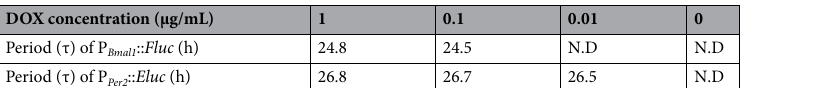
DOX concentration (µg/mL) 1 0.1 0.01 0 Period (τ) of P Bmal1 :: Fluc